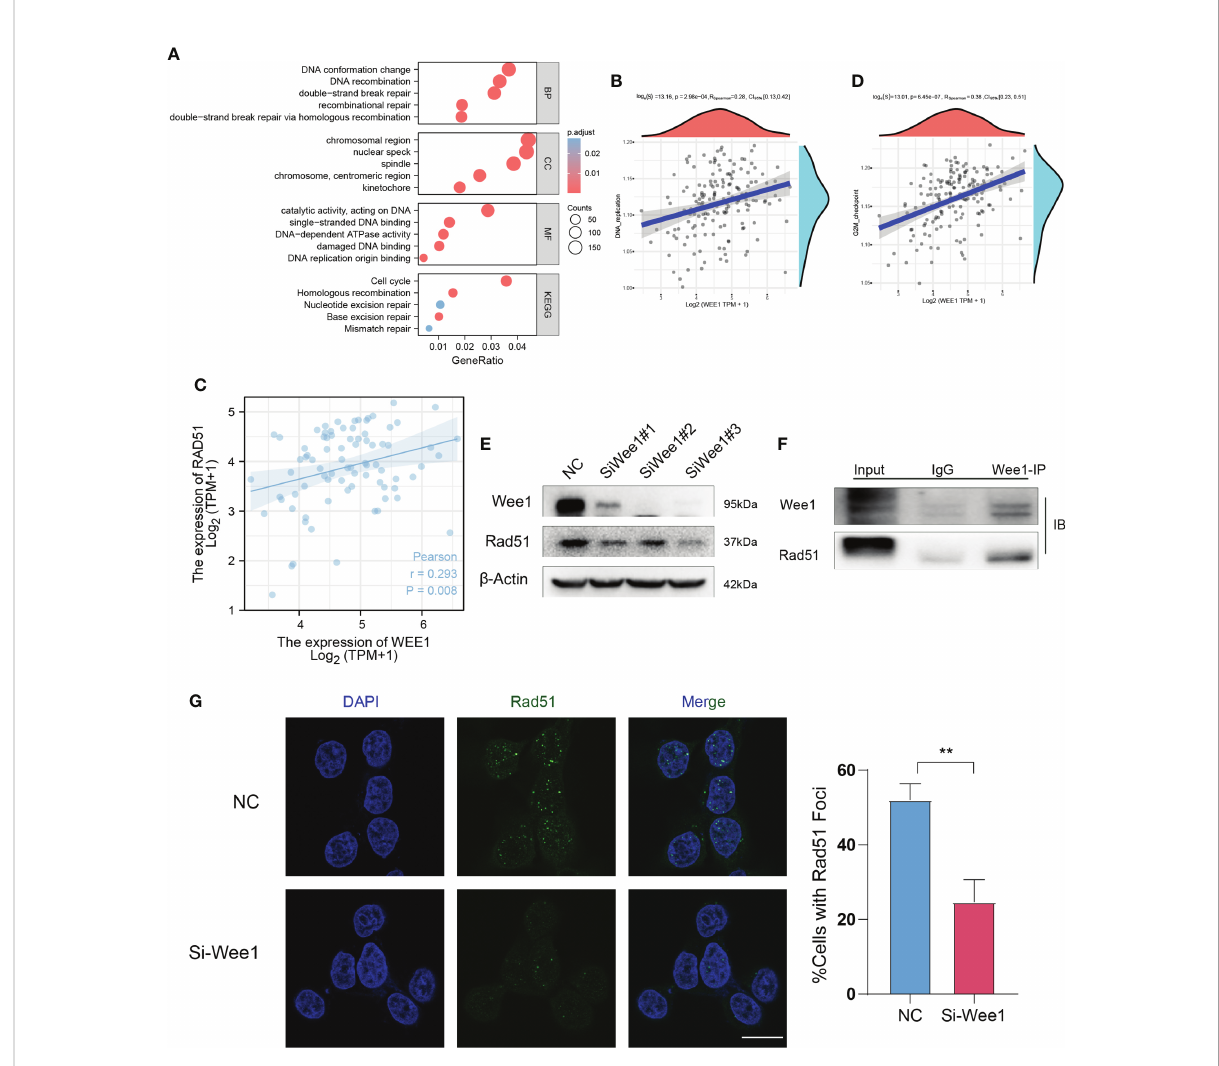
FIGURE 7 WEE1 interacts with Rad51 in ESCC cells. (A) KEGG/GO enrichment analysis shows that WEE1 and DNA damage repair is related. (B, C) Gene Set Enrichment Analysis (GSEA) shows enrichment for DNA replication and cell cycle. (D) WEE1 expression is statistically positively associated with Rad51. (E) Rad51 is downregulated with WEE1 inhibition in KYSE150 cells. (F) IP assay is performed to measure the interaction with WEE1 and Rad51 in KYSE150 cells. (G) Rad51 foci is measured in KYSE150 cells, Rad51 decreases in WEE1-inhibition cells. Scale bar = 10 m m (G) . **P < 0.01